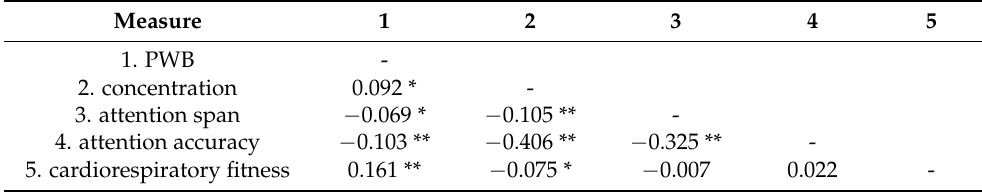
Table 2. Bivariate correlation among the study variables.